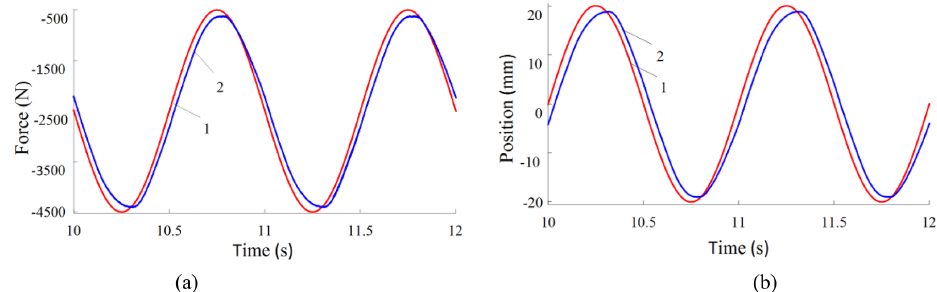
Figure 17. Real-time response curves of 1.0Hz. Real-time change curves of (a) driving force and (b) position.